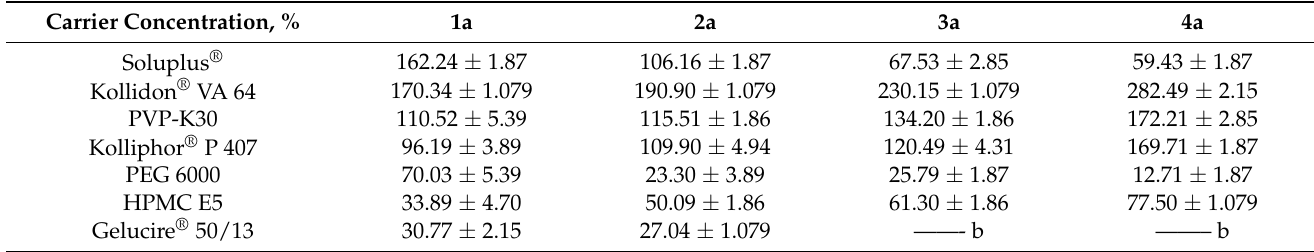
Table 3. Screening data of Irbesartan with different polymers at various